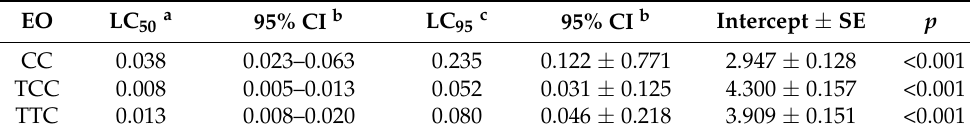
Table 5. Toxicity of three oregano chemotypes essential oils (EOs) to eggs of Calliphora vomitoria .